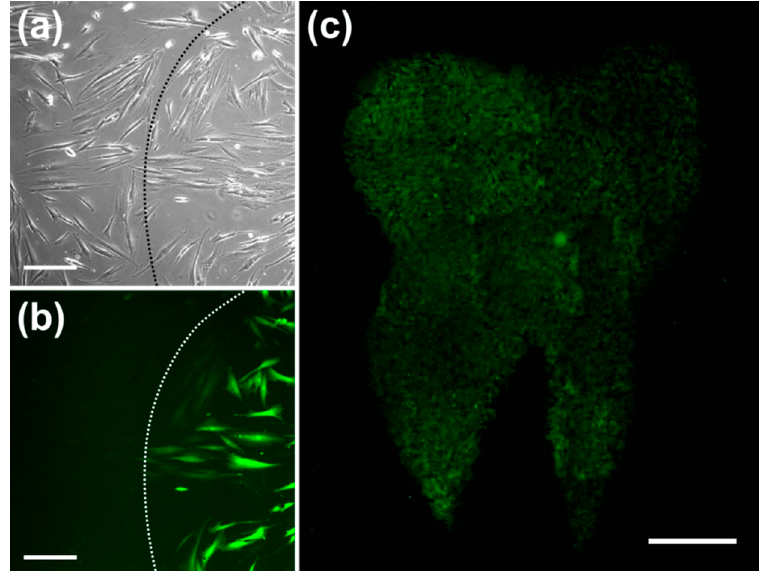
Figure 2. Perforation efficiency and percentage of non-necrotic cells irradiated with different radiant exposures (REs) for ( a ) pHFIB-G and ( b ) cell line ZMTH3 (statistical significance: p < 0.05). For all parameters the median as well as minimum and maximum percentages are shown ( n = 3).